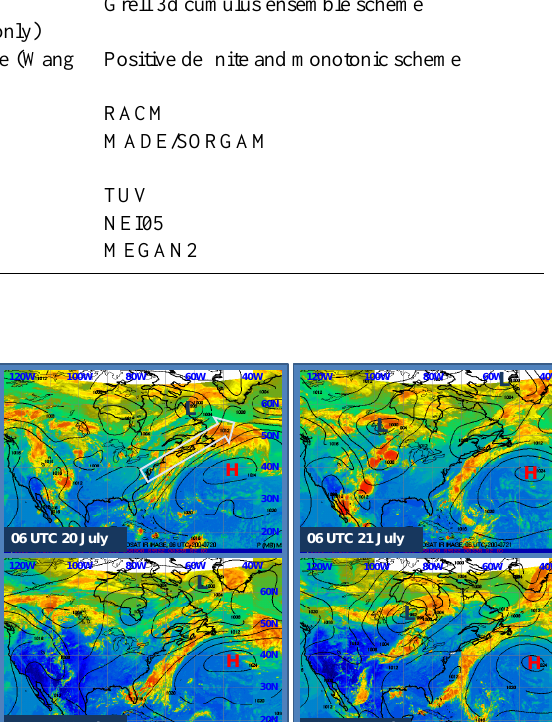
Table 1. Physical and chemical processes used for WRF-Chem model domain 1 (27km), domain 2 (9km), and domain 0 (60km). Category Setup (domains 1 and 2) Setup (domain 0) Shortwave radiation Simple shortwave scheme (Dudhia, 1989) Simple shortwave scheme Longwave radiation RRTM (Mlawer et al., 1997) RRTM Turbulence Mellor-Yamada-Janjic scheme (Janjic, 1990) Mellor-Yamada-Janjic scheme Land surface process Noah LSM with UCM Noah LSM with UCM (Chen and Dudhia, 2001) Grid-scale clouds WRF single-moment 5-class scheme (Hong et WRF single-moment 5-class scheme al., 2004) Subgrid-scale clouds Grell-Devenyi ensemble scheme Grell 3d cumulus ensemble scheme (Grell and Devenyi, 2002) (Domain 1 only) Positive definite and monotonic scheme